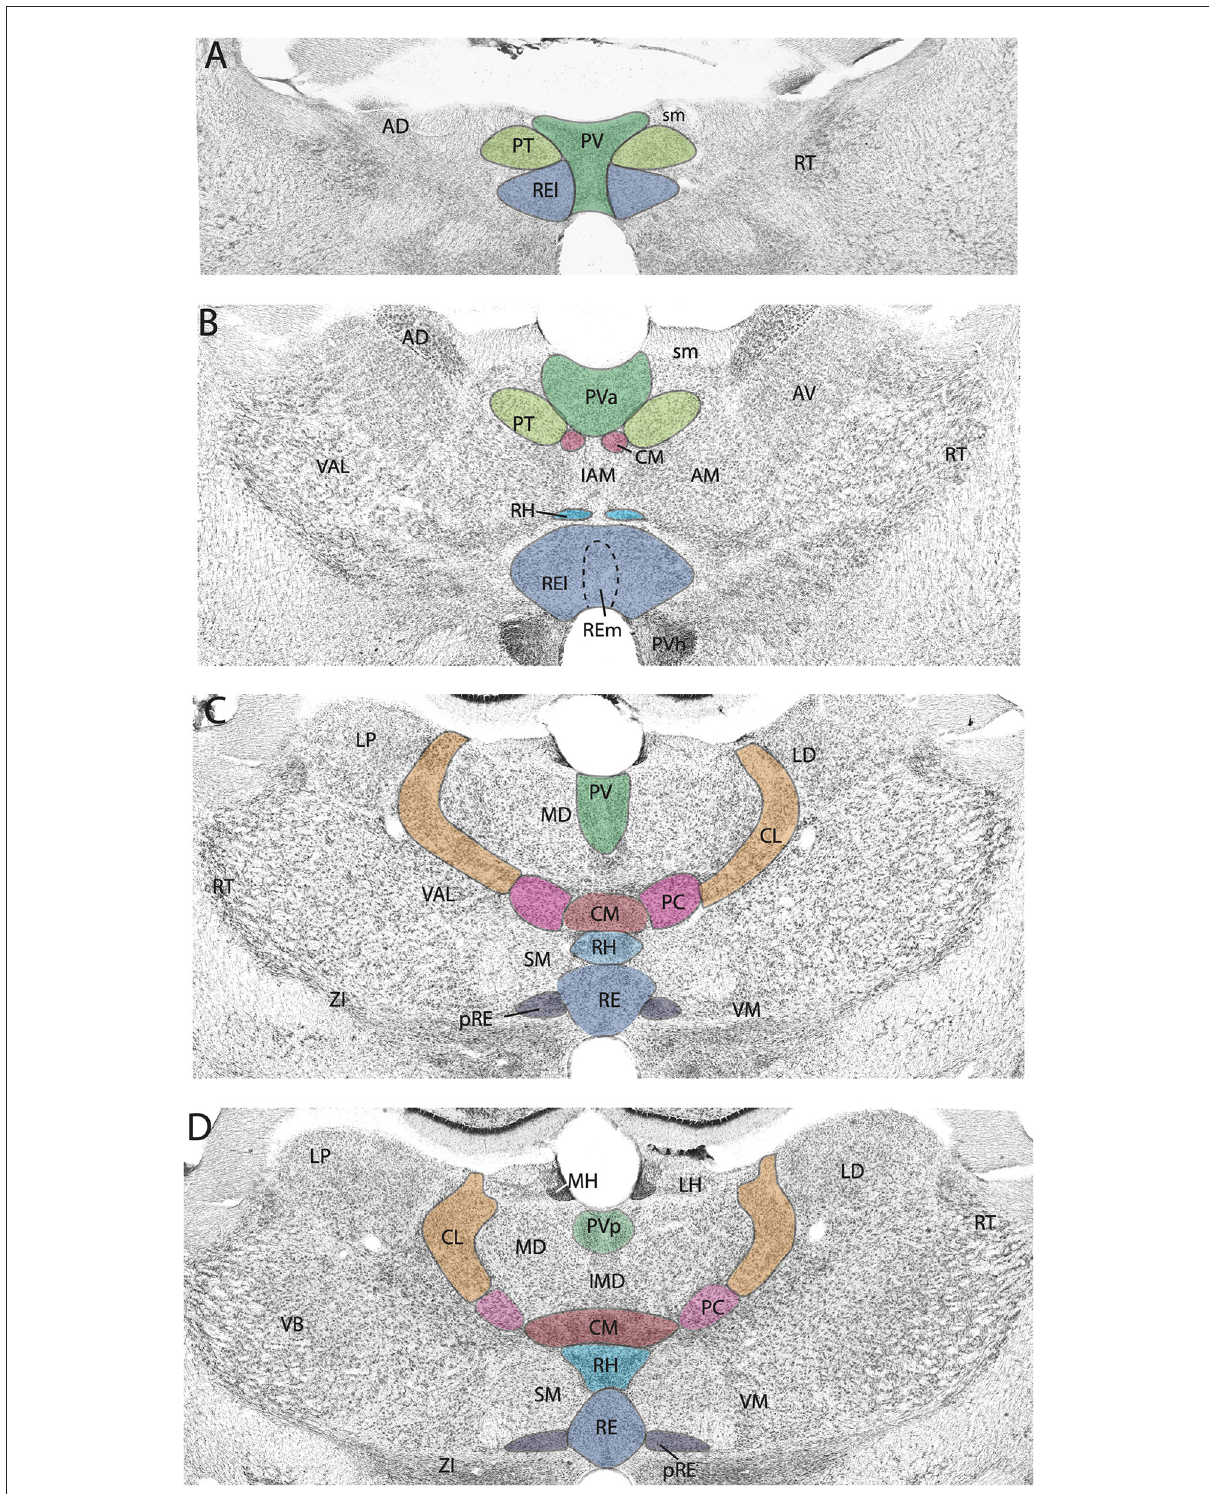
FIGURE1 (A–D) Nissl-stained micrographs of transverse sections through the diencephalon of the rat depicting nuclei of the thalamus at four anterior to mid-levels of the thalamus. Colored-coded sections show the locations of the midline and rostral intralaminar nuclei of the thalamus. The midline nuclei consist of the paraventricular (PV) and paratenial (PT) of the dorsal midline thalamus and the rhomboid (RH) and reuniens (RE) nuclei of the ventral midline thalamus. The rostral intralaminar nuclei consists of the central medial (CM), paracentral (PC), and central